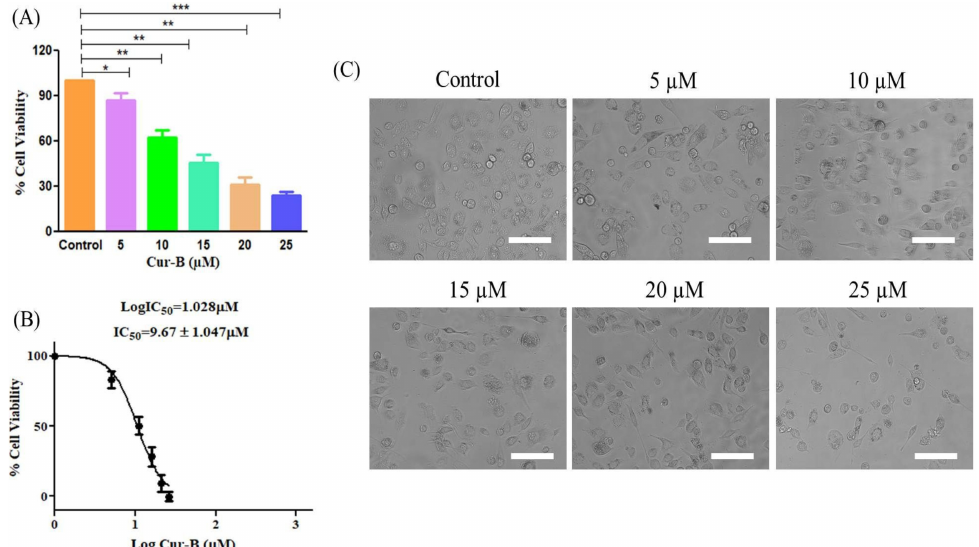
Figure 1. Cytotoxic effects of Cur-B against PC-3 cells as evaluated through MTT assay: ( A ) changes in cell viability percentage, ( B ) IC 50 value of Cur-B against PC-3 cells and ( C ) changes in morphology of PC-3 cells upon exposure to various Cur-B concentrations after 24 h. Scale bar = 100 µ m. * p < 0.05, ** p < 0.01, *** p <